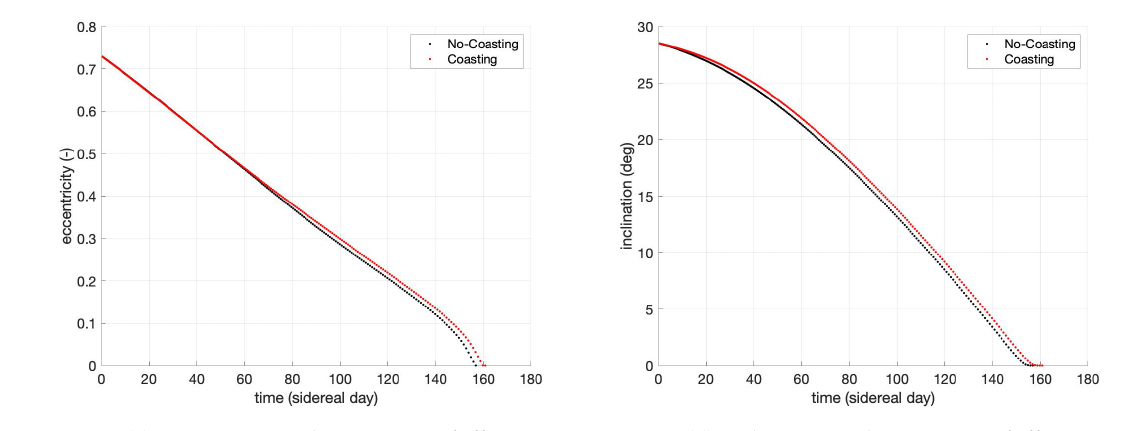
Figure 8. Osculating orbital elements of GTO-GEO trajectory.